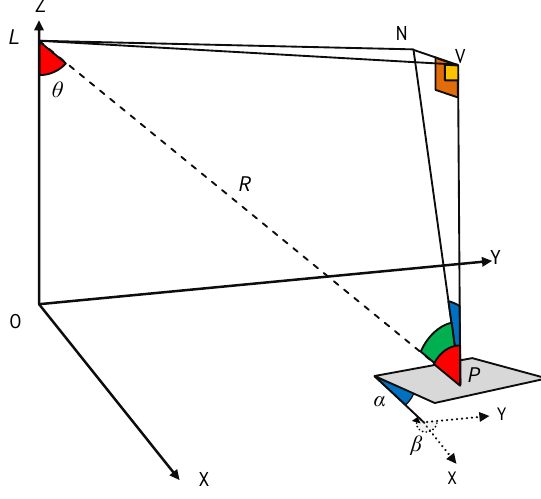
Figure 2. Illustration of the geometric relationship between the LiDAR sensor ( L ) and the surface of the ground object ( P ) In order to compute the angle of reflection ∠ LPN the three vectors ( LP → , PN → , and LN → ) in the triangle LPN should be used. LP → is the range vector which is measured by the LiDAR sensor. The → and → can be calculated from the following PN LN